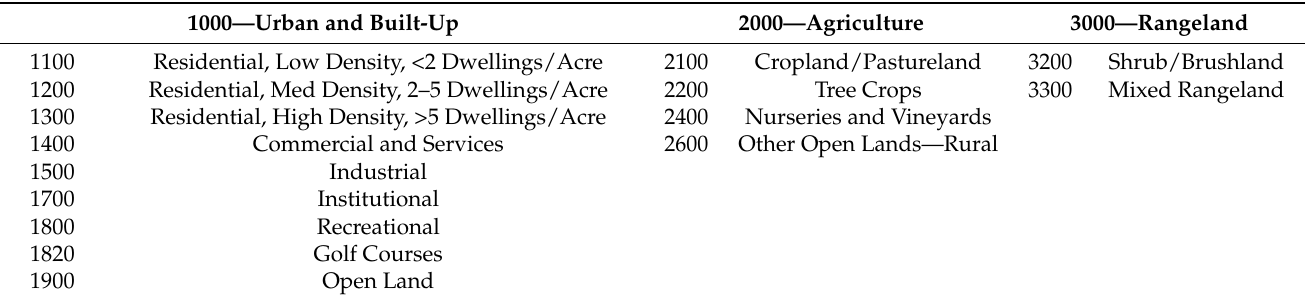
Table 1. Initial SWFWMD Level II FLUCCS sub-classes for the “Urban and Built-up”, “Agriculture”, and “Rangeland” Level I classes.